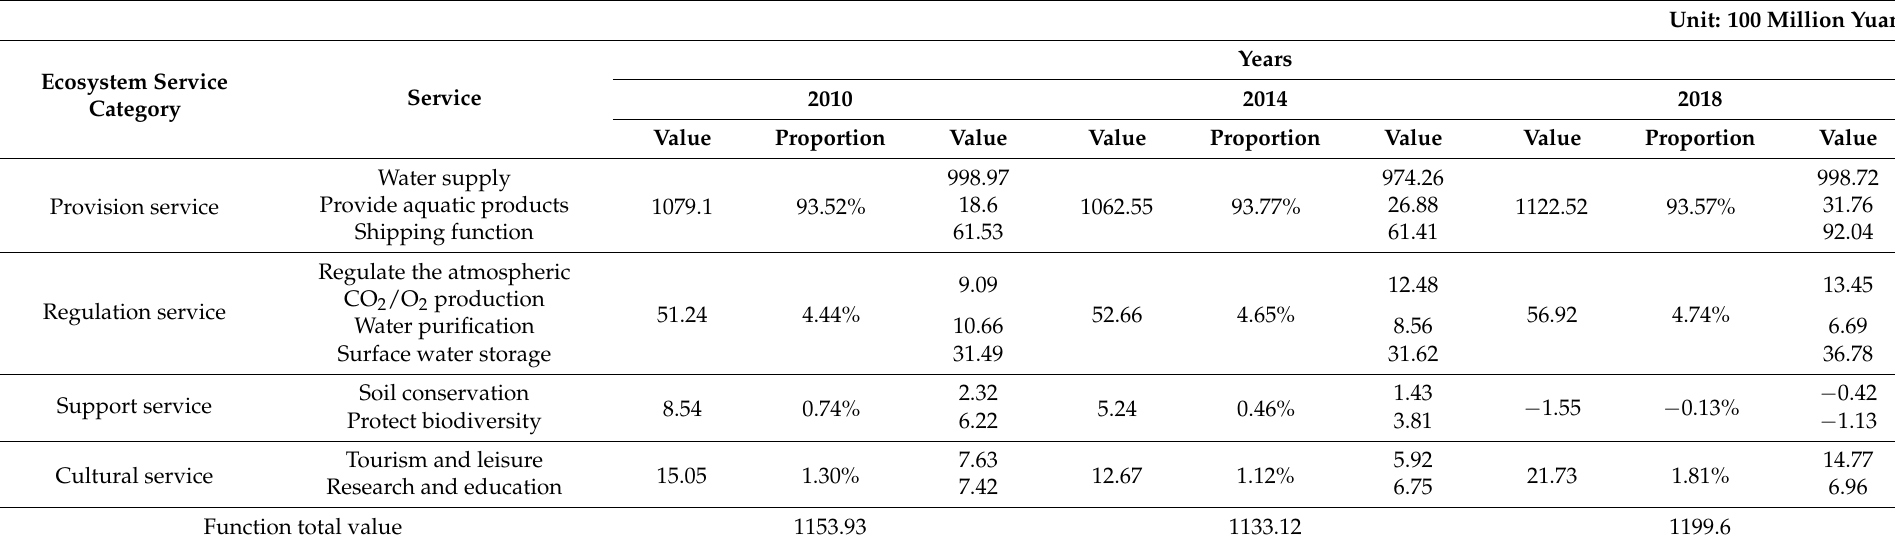
Table 13. Taihu Lake water ecosystem service value comparison during 2010–2014.